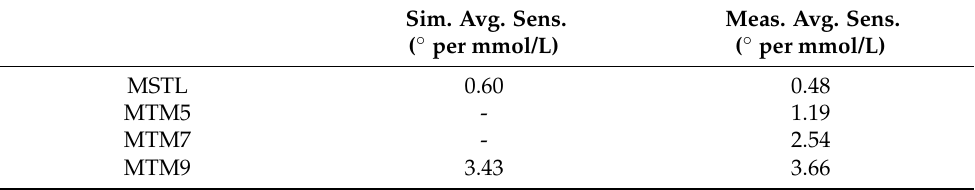
Table 6. Average sensor sensitivity at frequency 1.99 GHz for simulation and measurement. Sim. Avg.